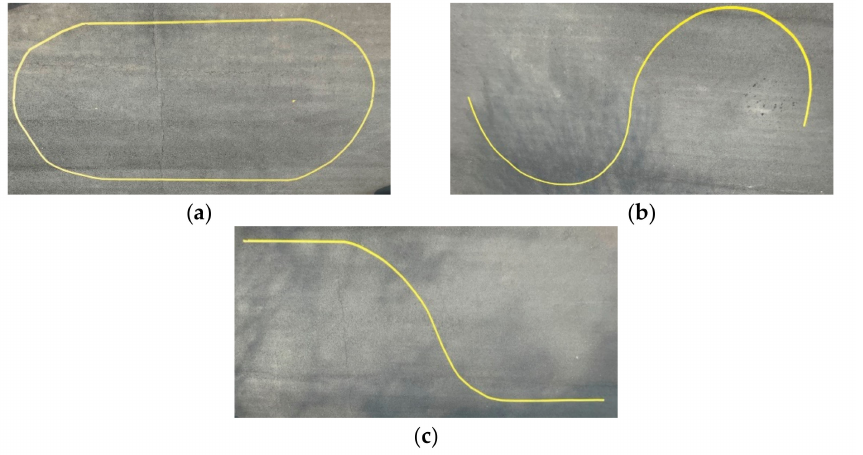
Figure 9. ( a ) Ellipse-path tracking scenario; ( b ) S-curved path tracking scenario; ( c ) lane-change path tracking